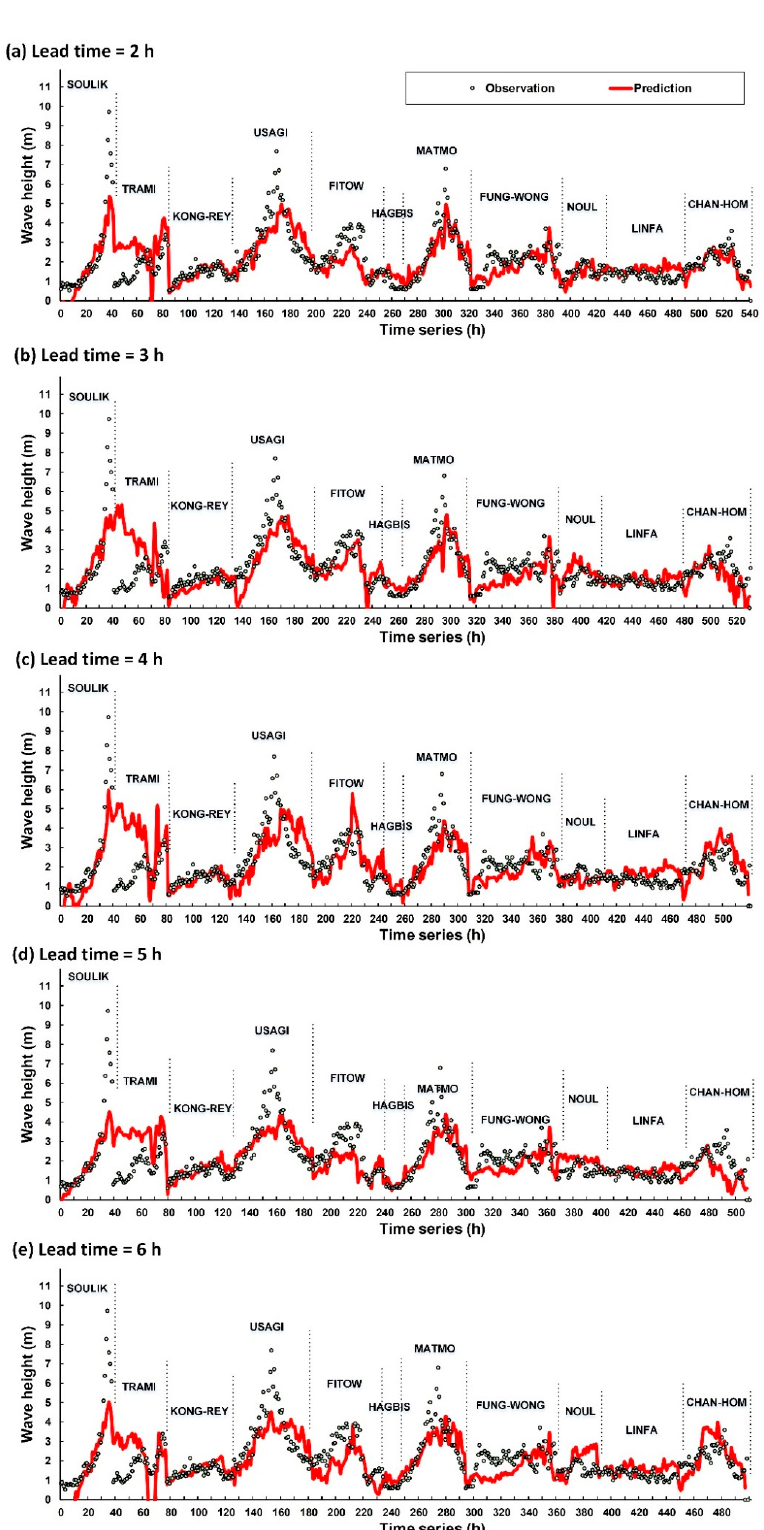
Figure 12. Wave height prediction of lead time = 2 to 6 h at Longdong buoy: ( a ) lead time = 2 h;